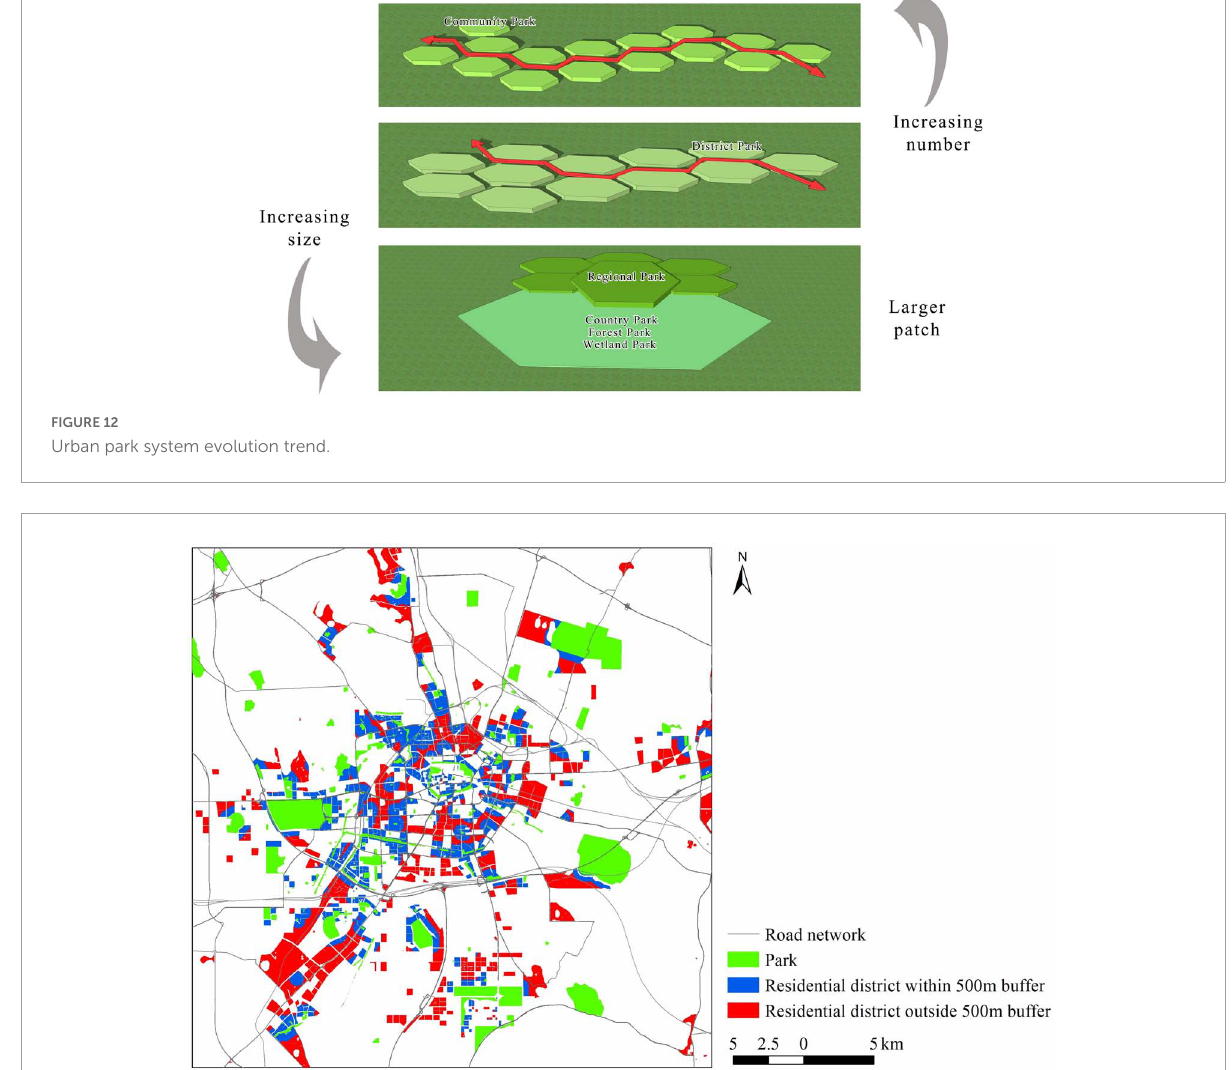
FIGURE13 Distribution of the residential districts based on 500 m buffer of the